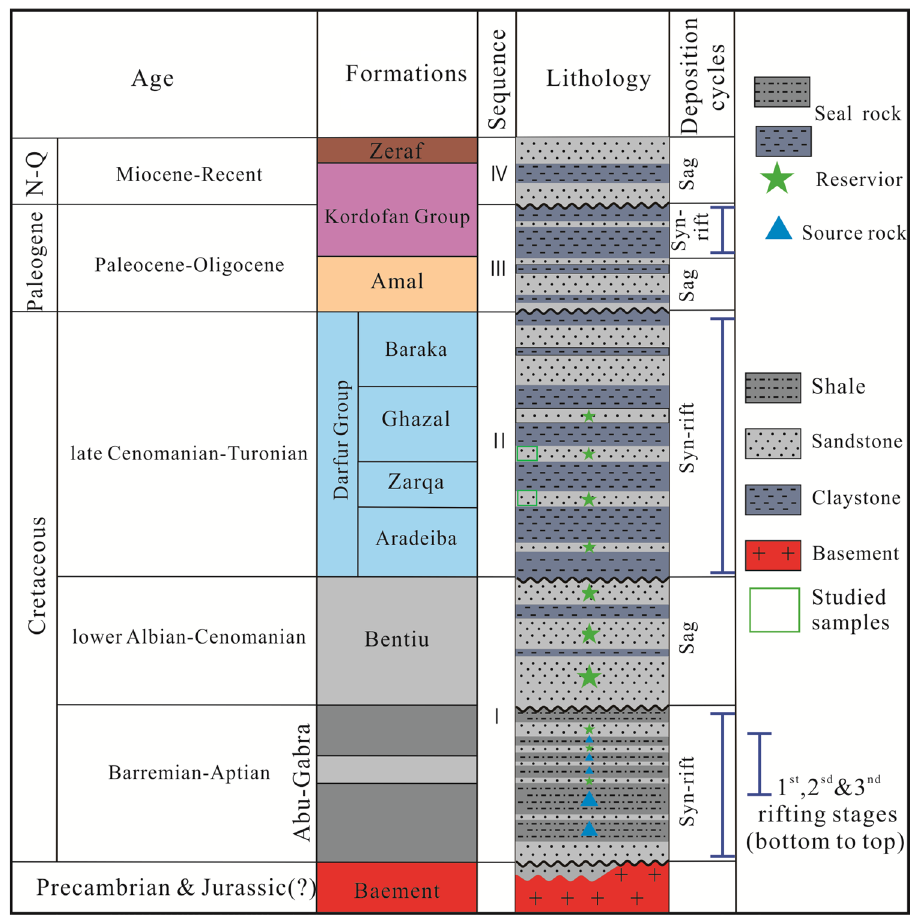
Figure 2. The main stratigraphic column of the Northeastern region of the Muglad Basin. It compares sediments succession from Late Jurassic/Early Cretaceous—Quaternary with four sequences (I–IV) that separated by